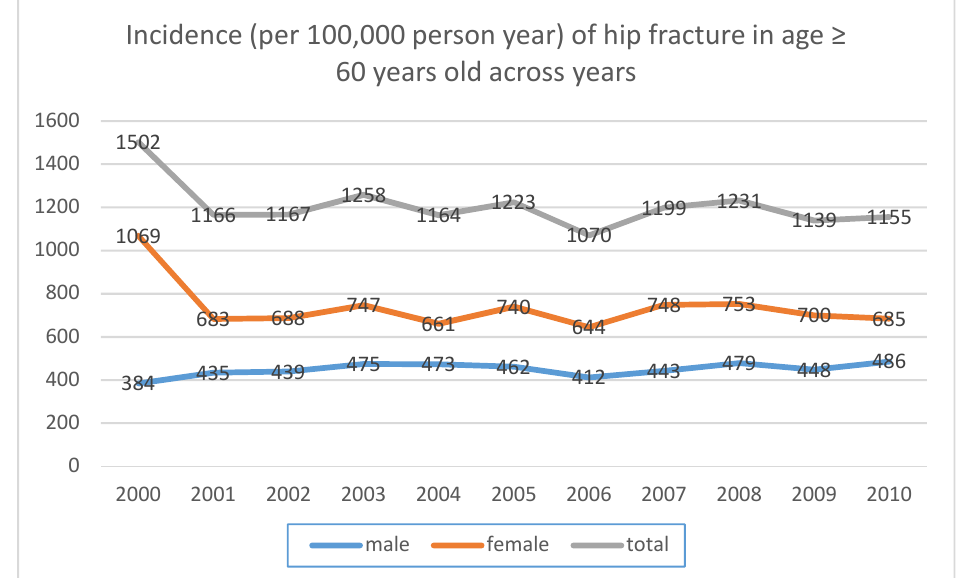
Figure 2. Incidence (per 100,000 persons per year) of hip fracture in across years.